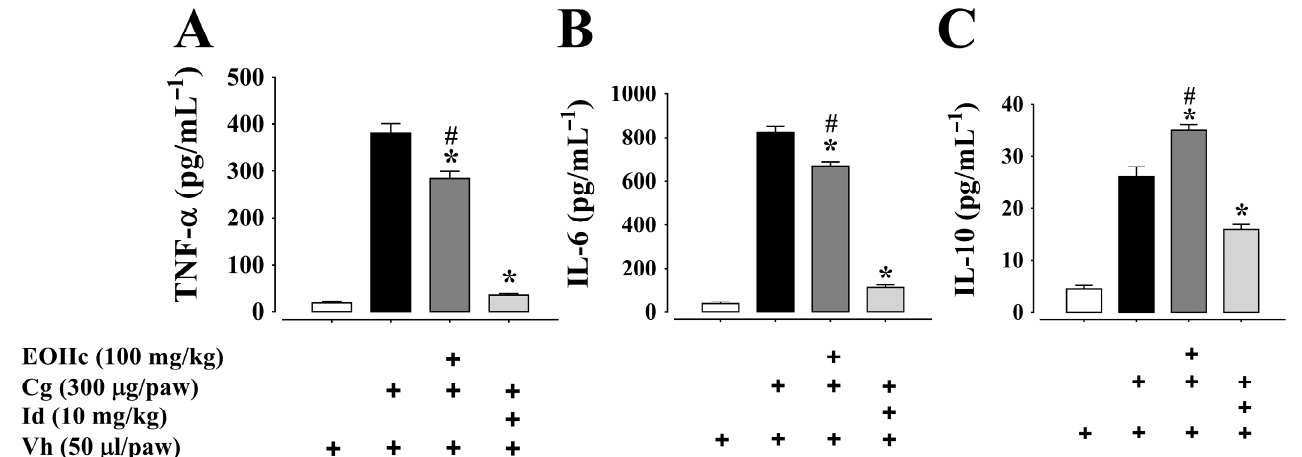
Figure 4. Effect of essential oil of Hyptis crenata (EOHc) 100 mg/kg on TNF- α ( A ), IL-6 ( B ), and IL-10 ( C ) on 3rd h of edema induced by carrageenan. EOHc or the vehicle (0.1% Tween 80) was administered, orally, 1 h before carrageenan intra-plantar injection for edema induction. The dosage of cytokines was made in paw homogenate at the peak of edema (3 h) induced by intra-plantar injection of carrageenan (Cg, 300 µ g/paw,) or of its vehicle (Vh, 0.9% NaCl solution, 50 µ L/paw). Id, indomethacin (positive control). *, p < 0.05, vs. carrageenan; #, p < 0.05 vs. positive control (One-way ANOVA followed by Bonferroni´s test). n (number of animals) = 6 for all panels. “+” means in presence of.